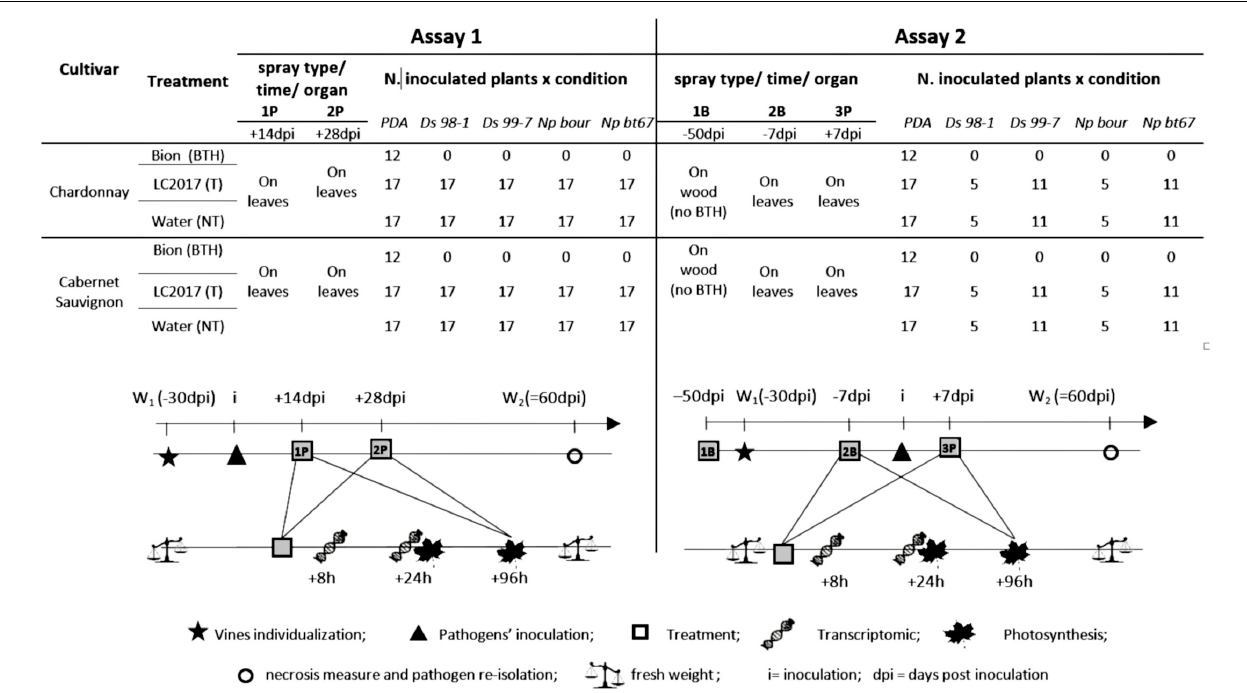
Frontiers in Plant Science |